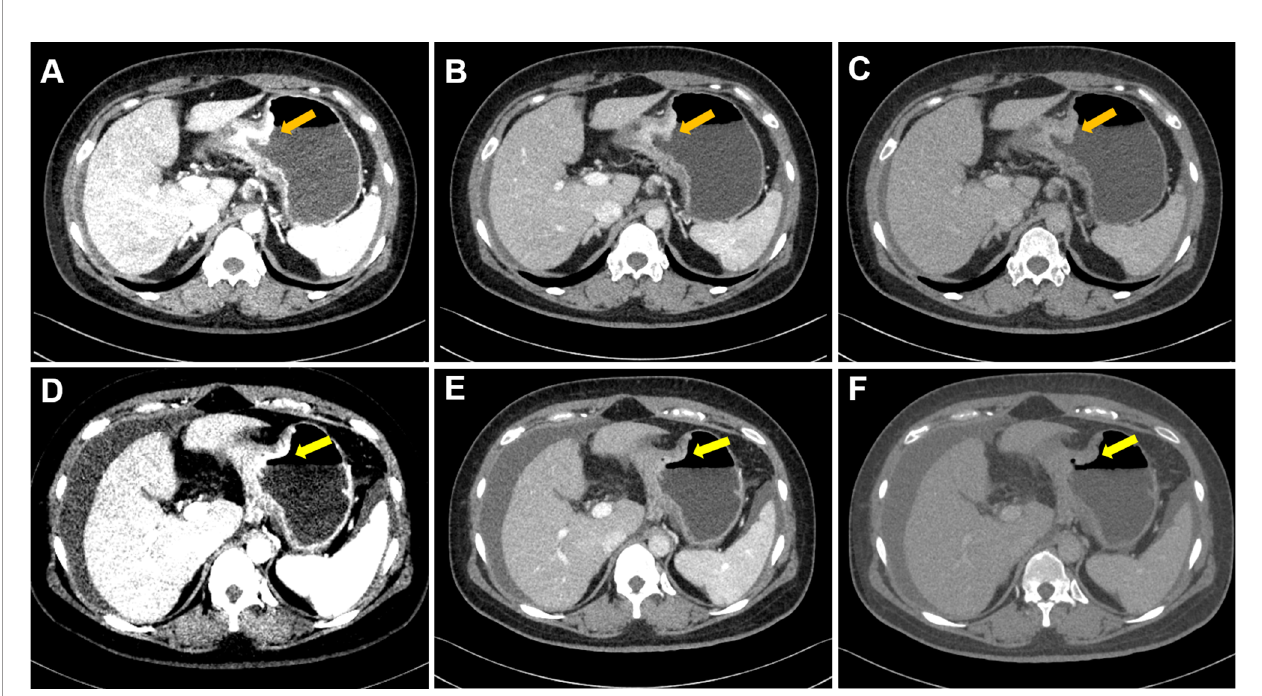
FIGURE 2 | Case 2. Portal phase DECT images of a 40-year-old female patient with GC who did not respond to chemotherapy. (A – C) An irregular wall-thickening lesion at the gastric body was present (arrow). (D – F) There was no obvious change (slightly regression) in the lesions of gastric body (arrow). (A – C) were monochromatic images of 40, 70, and 100 keV before chemotherapy, respectively; (D – F) were monochromatic images of 40, 70, and 100 keV after chemotherapy, respectively. Note: After completion of chemotherapy, the patient was diagnosed with aggravated peritoneal